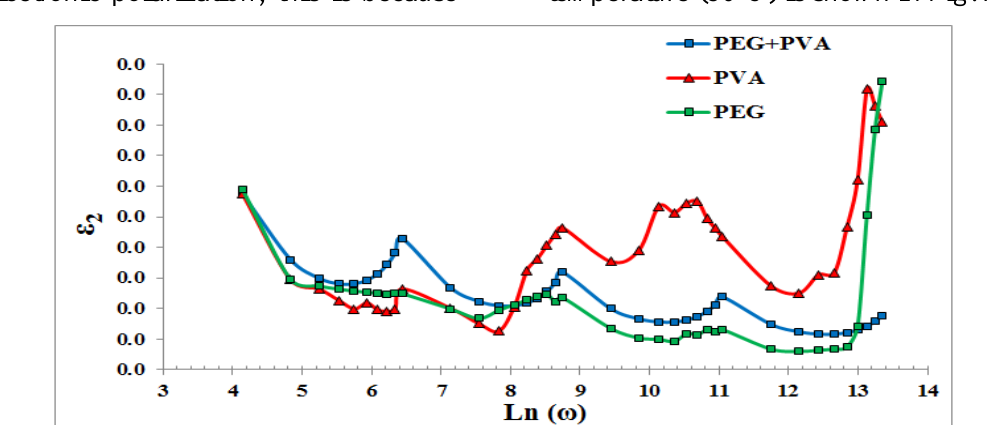
Fig. 4A: Variation of the dielectric loss with frequency for PVA, PEG and PVA:PEG